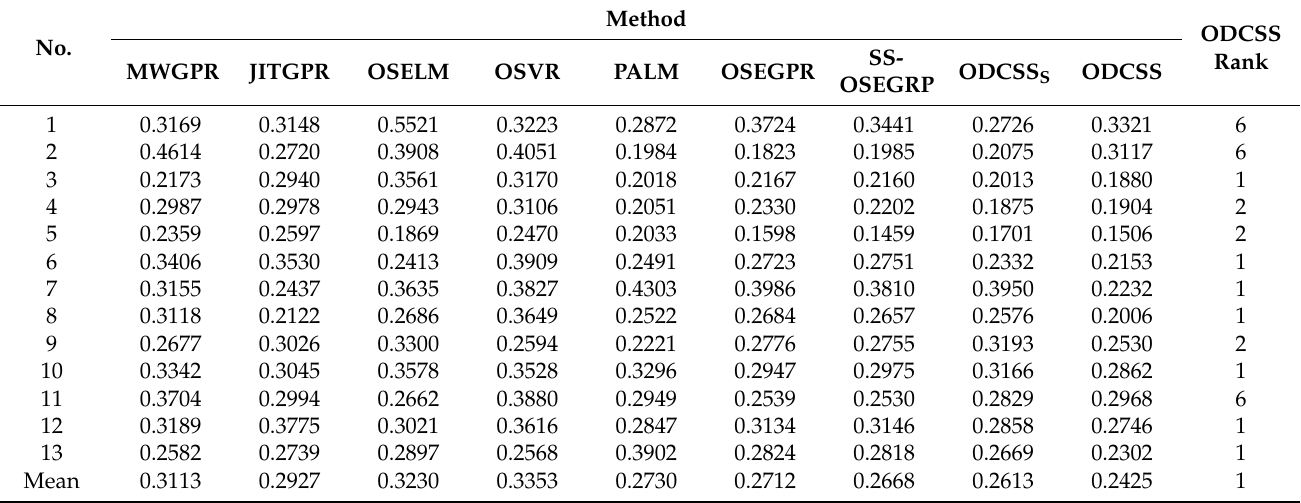
Table 10. The prediction RMSE values of different soft sensor methods on the test batches in CTC fermentation